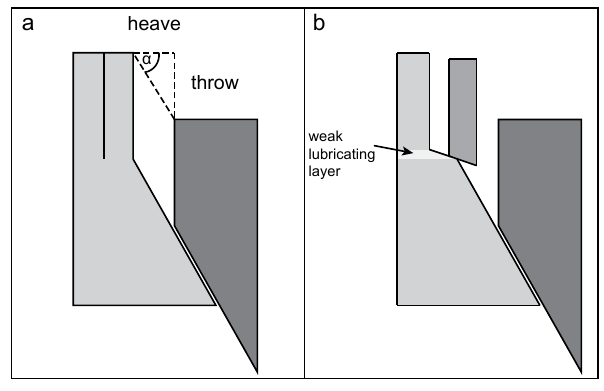
Figure 15. (a) Geometric relation between heave, throw and fault dip. (b) Lubricating layer can cause large blocks to break